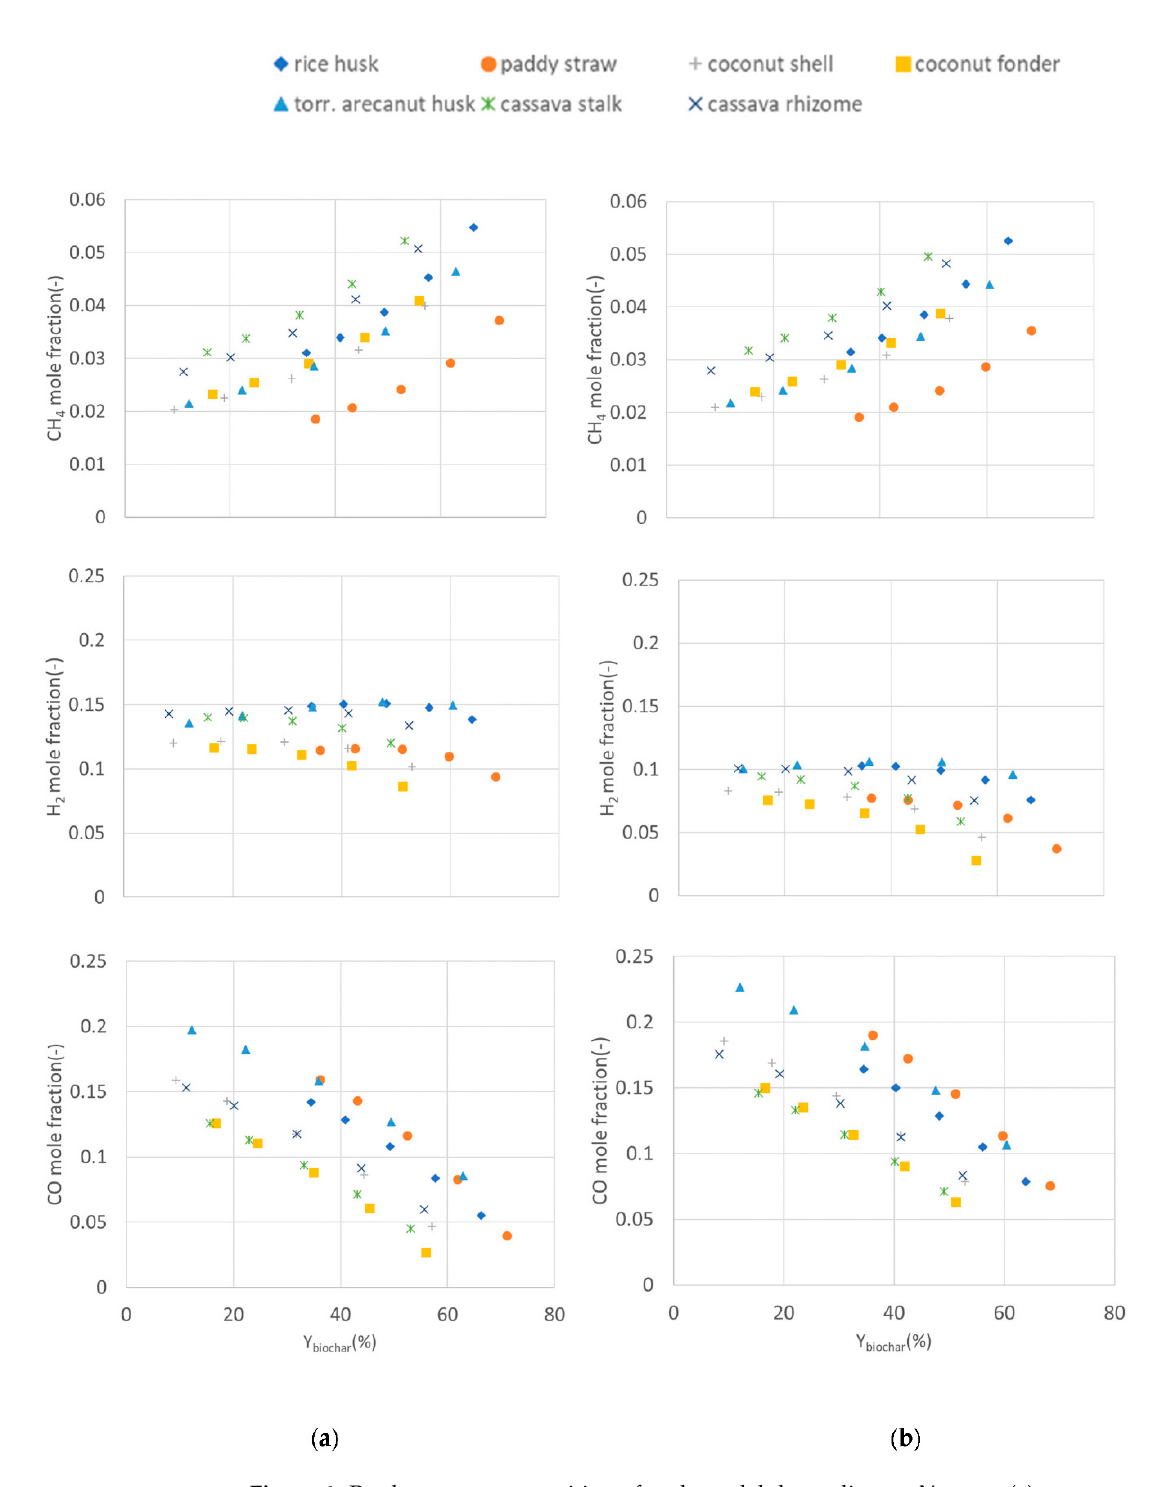
Figure 6. Producer gas composition of each model depending on Y biochar : ( a ) two-reactor model, ( b ) three-reactor model.